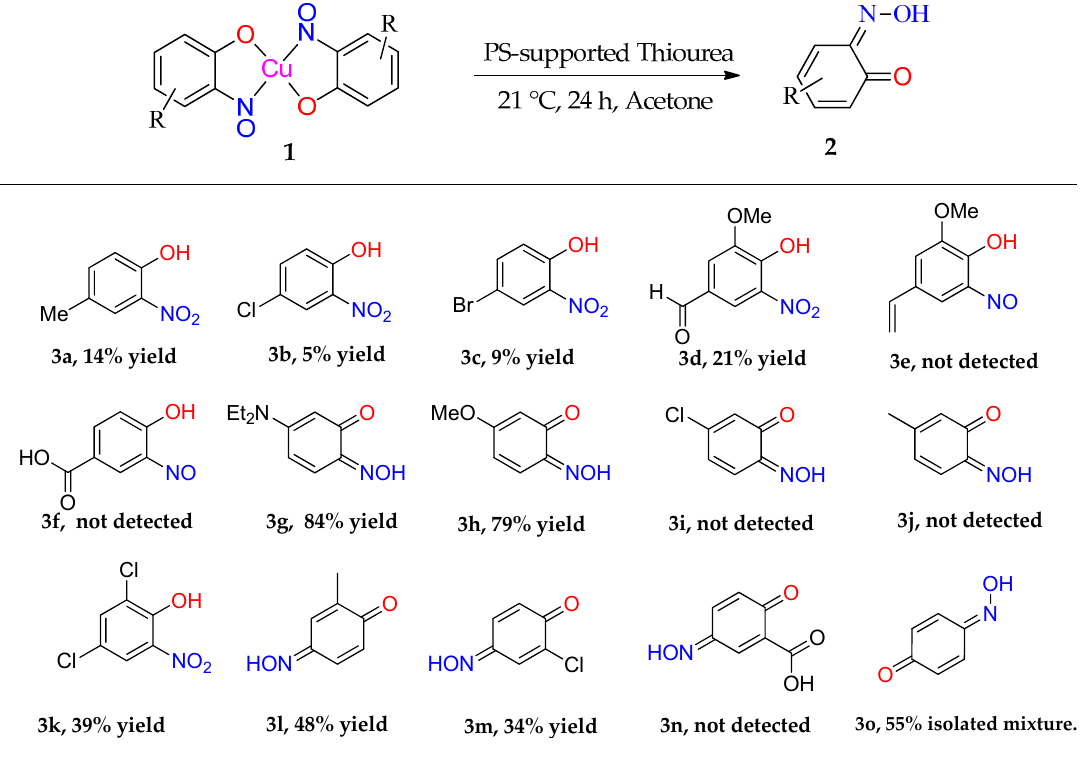
Table 2. Organic ligand isolation from copper(nitrosophenolato)